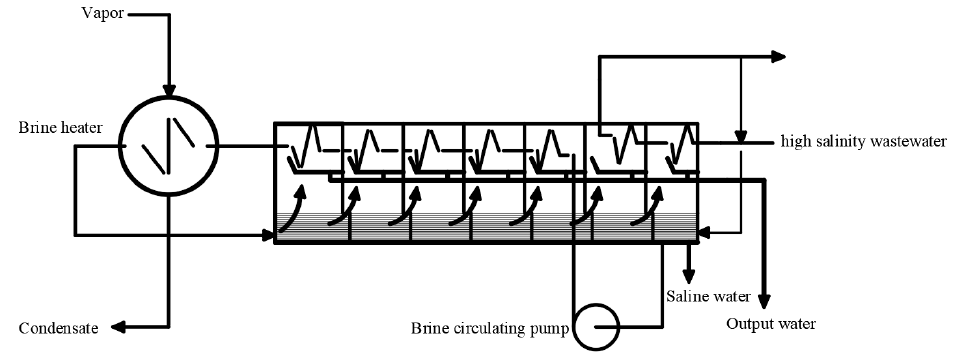
Figure 1. Multi-stage flash process.